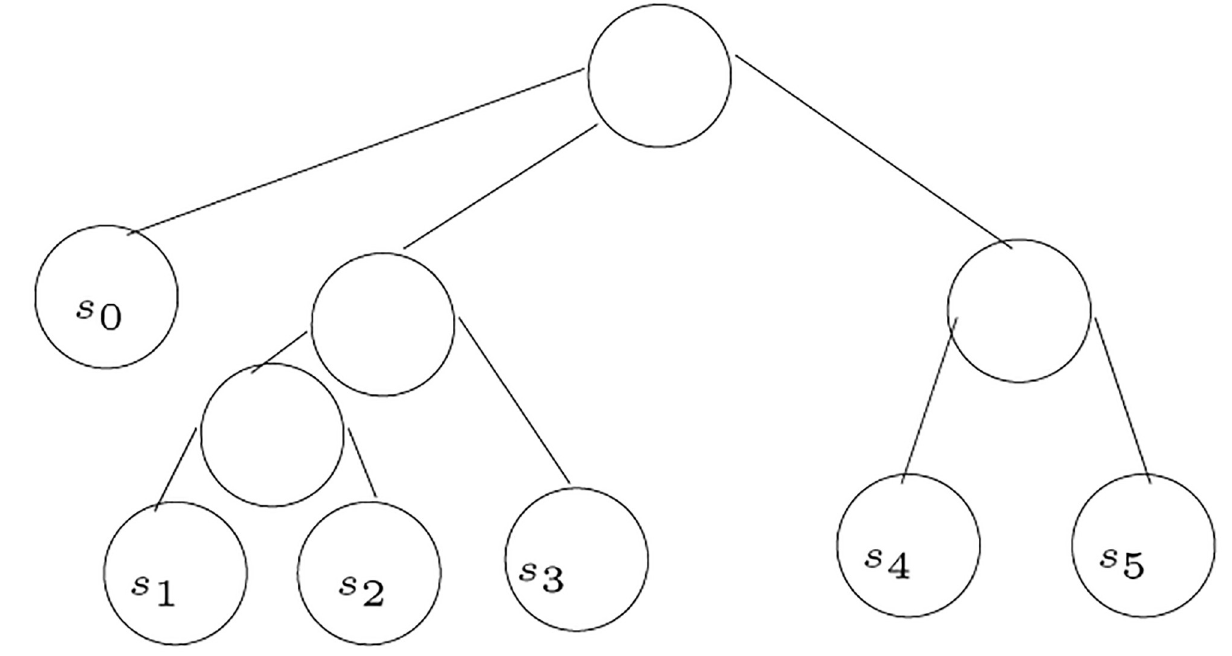
Fig 31. An example to illustrate the algorithm ConstructTree2Partitions.